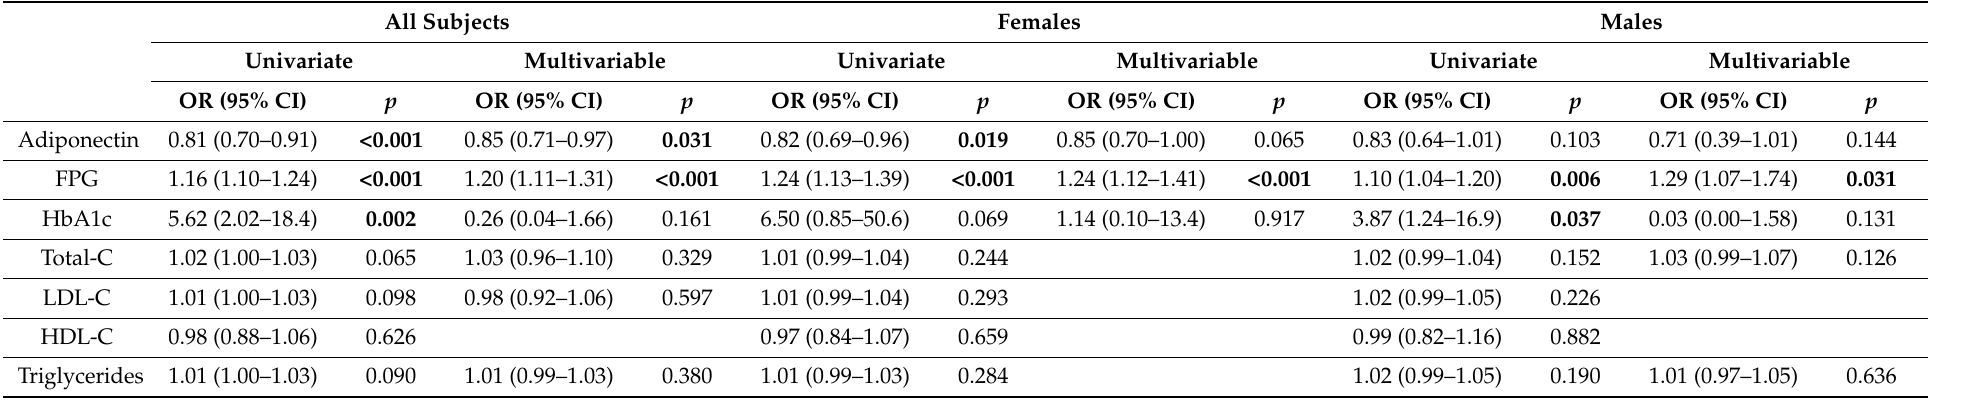
Table 4. Logistic regression analysis of blood variables reflecting metabolic syndrome components or lipid profiles for predicting multi-MetSC in subjects with extremely high HDL-C